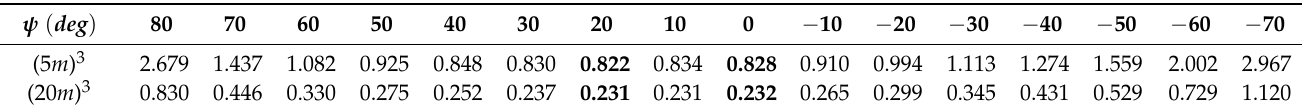
Table 7. The 3D RMSPE ∆ p (m) with varying ψ in the 5 m × 5 m × 5 m and 20 m × 20 m × 20 m environments for the LOS condition.